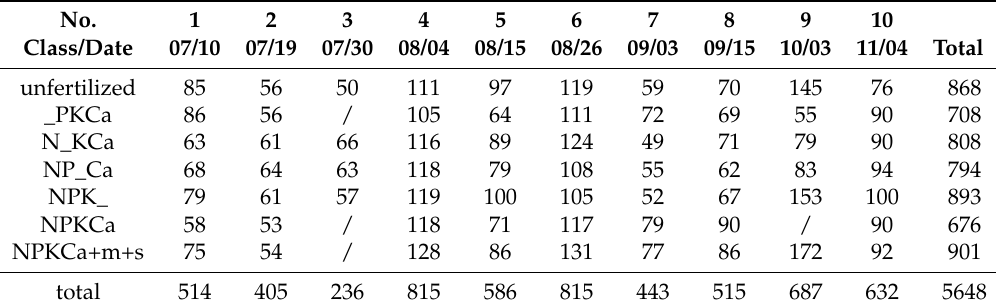
Table 1. The number of images in the Deep Nutrient Deficiency for Sugar Beet (DND-SB) dataset for the training and test set. “_” stands for the omission of the corresponding nutrient, 07/10 denotes 10 July 2019, where 2019 is omitted for